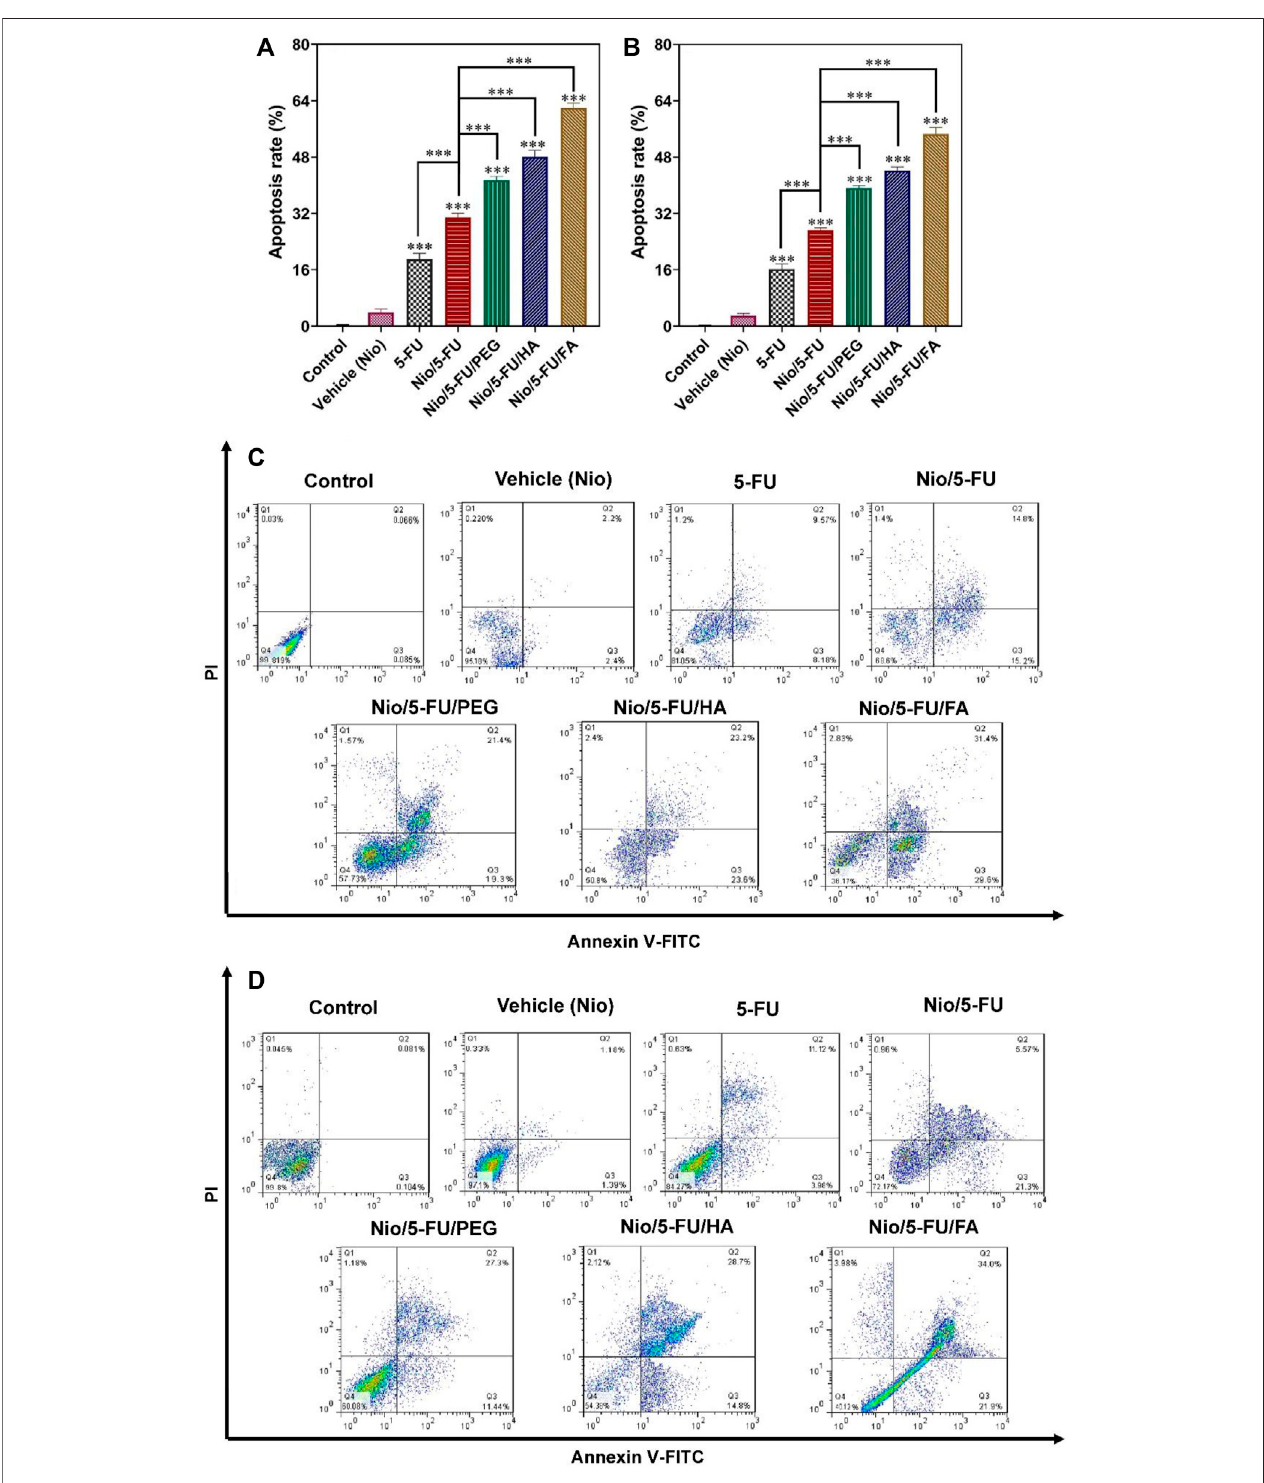
FIGURE6| Theeffects ofcontrol, 5-FUand differentniosomeformulations(Nio), 5-FU, Nio/5-FU,Nio/5-FU/PEG, Nio/5-FU/HA and Nio/5-FU/FA of (A) MCF7 and (B) 4T1breastcancercellsthatbecameapoptoticafter48 hoftreatment.Datarepresentmeans±standarddeviations( n =3).Forallcharts,***: p < 0.001;**: p < 0.01;*: p < 0.05. (C,D) Flowcytometricanalysisof(C)MCF7and(D)4T1cellsaftertreatmentwithIC50concentrationofvehicle(Nio),5-FU,Nio/5-FU,Nio/5-FU/PEG,Nio/5-FU/ HAandNio/5-FU/FAformulations.Theupperleftsquare(Q1)showsthepercentageofnecroticcells,andtheupperrightsquare(Q2)exhibitsthepercentageoflate apoptotic cells, (Q3) exhibits the percentage of early apoptotic cells, and (Q4) shows the percentage of live cells.